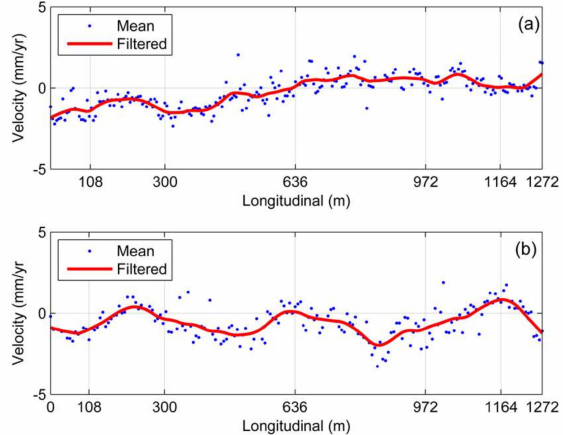
Figure 9. Average cross thermal dilation parameters in the longitudinal direction. The figure marked with ‘( a )’ is related to Track 01, and that marked with ‘( b )’ refers to Track 02.